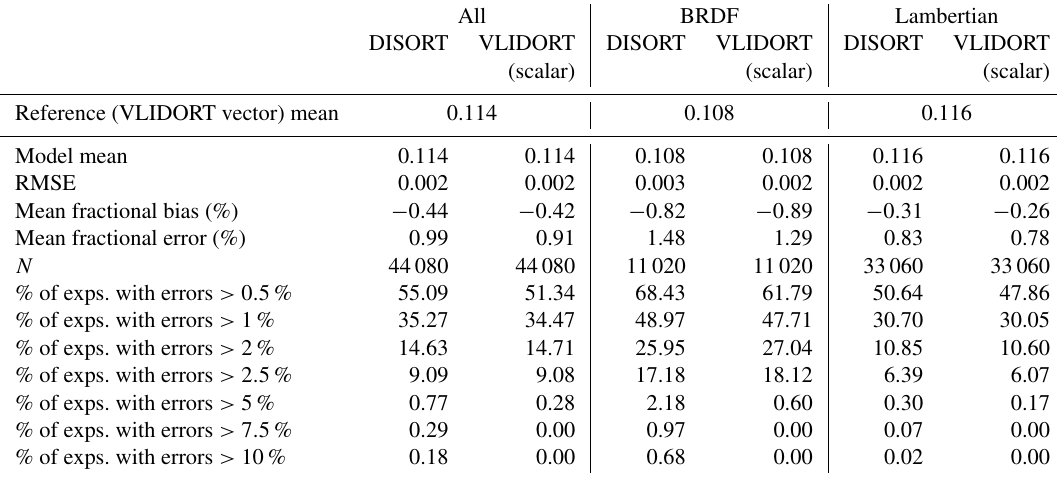
Table 3. Statistical measures of DISORT and scalar VLIDORT reflectances against vector VLIDORT (first row). Errors of the last rows are defined as the absolute value of the relative error, using the VLIDORT (vector) reflectance as the reference. VLIDORT is the configuration with 32 streams and the TMS correction activated. N refers to the number of